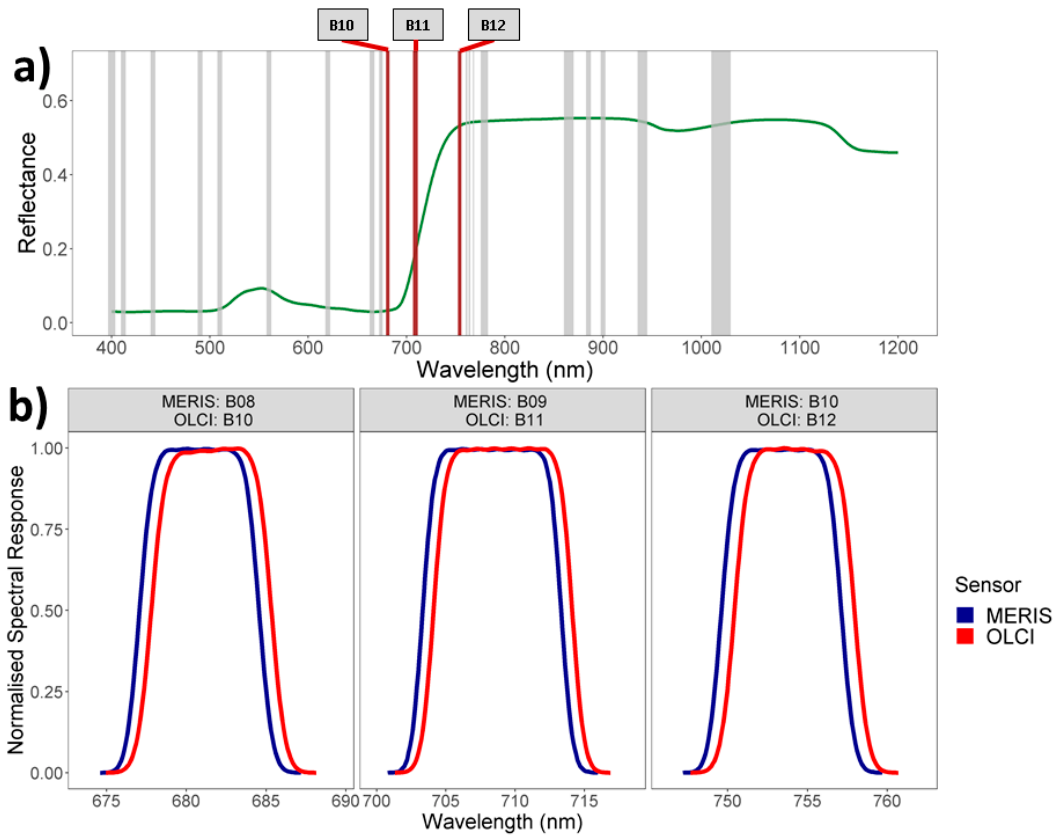
Figure 2. Sentinel-3 OLCI spectral bands over a typical vegetation spectral response ( a ). The red bars represent the bands used for the computation of Sentinel-3 OTCI while grey bars are the other 18 OLCI bands. OLCI bands 10, 11, and 12 centred at 681.25, 708.75, and 753.75 nm and MERIS bands 8, 9, and 10 also centred at 681.25, 708.75, and 753.75 nm ( b ).